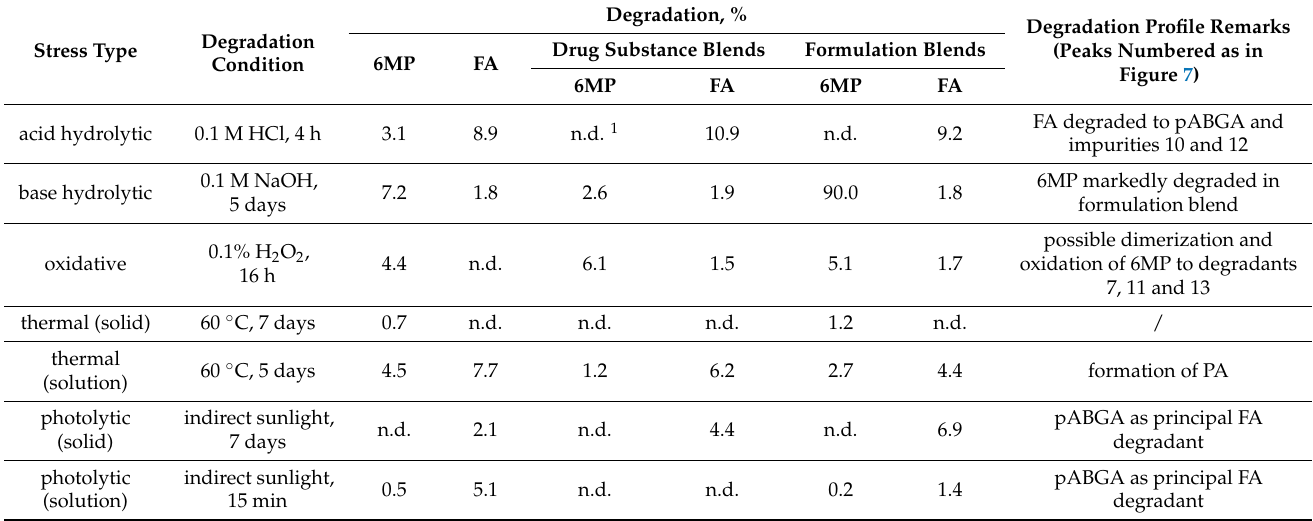
Table 4. Results of the forced degradation